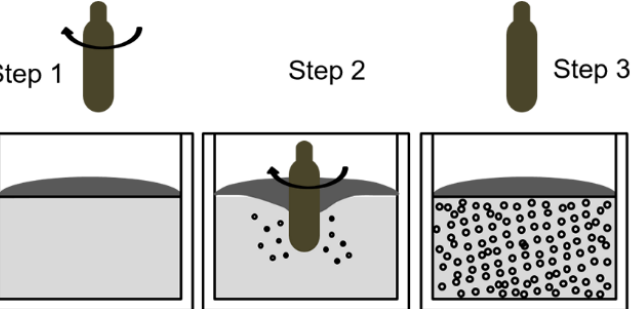
Figure 10. Illustration of the steps of the Semi-solid rheocasting, in which molten alloy is held above the liquidus (Step 1), then rapidly cooled and agitated for a controlled duration to a temperature below the liquidus (Step 2) before agitation and cooling ceases (Step 3) [125].